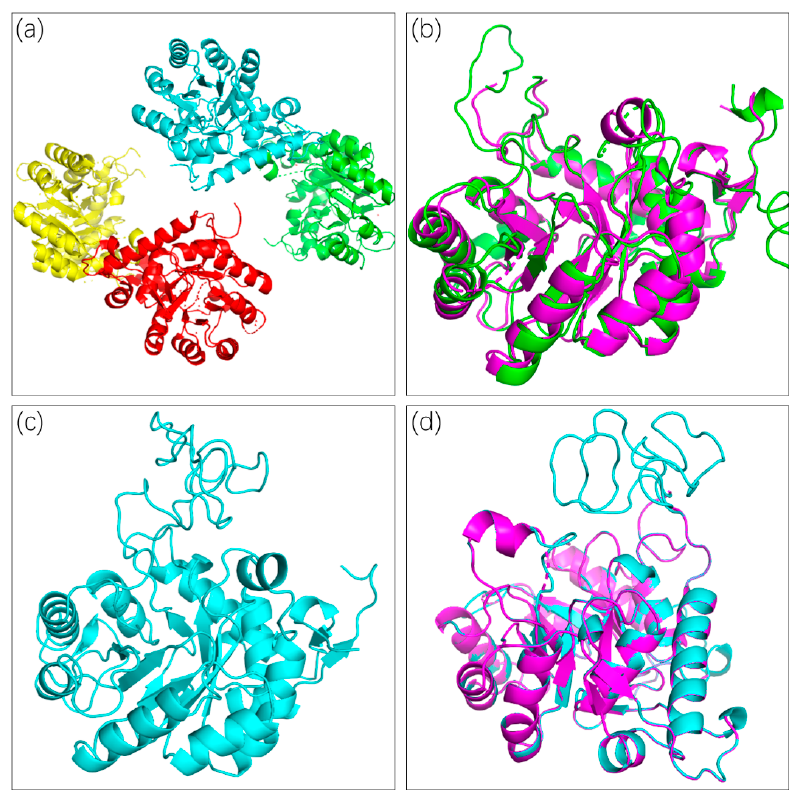
Figure 2. Crystal and Loop Refinement structure of the apo-form C Las IMPDH ∆ 98-201. ( a ): Tetramer of C Las IMPDH ∆ 98-201; ( b ): Superposed structures of C Las IMPDH ∆ 98-201 (PDB entry: 6KCF, in magenta) and B aIMPDH ∆ 95-200 (PDB entry: 4MJM, in green); ( c ): Loop refinement of C Las IMPDH ∆ 98-201; ( d ): Superposed structures of C Las IMPDH ∆ 98-201 (PDB entry: 6KCF, in green) and the refined structure